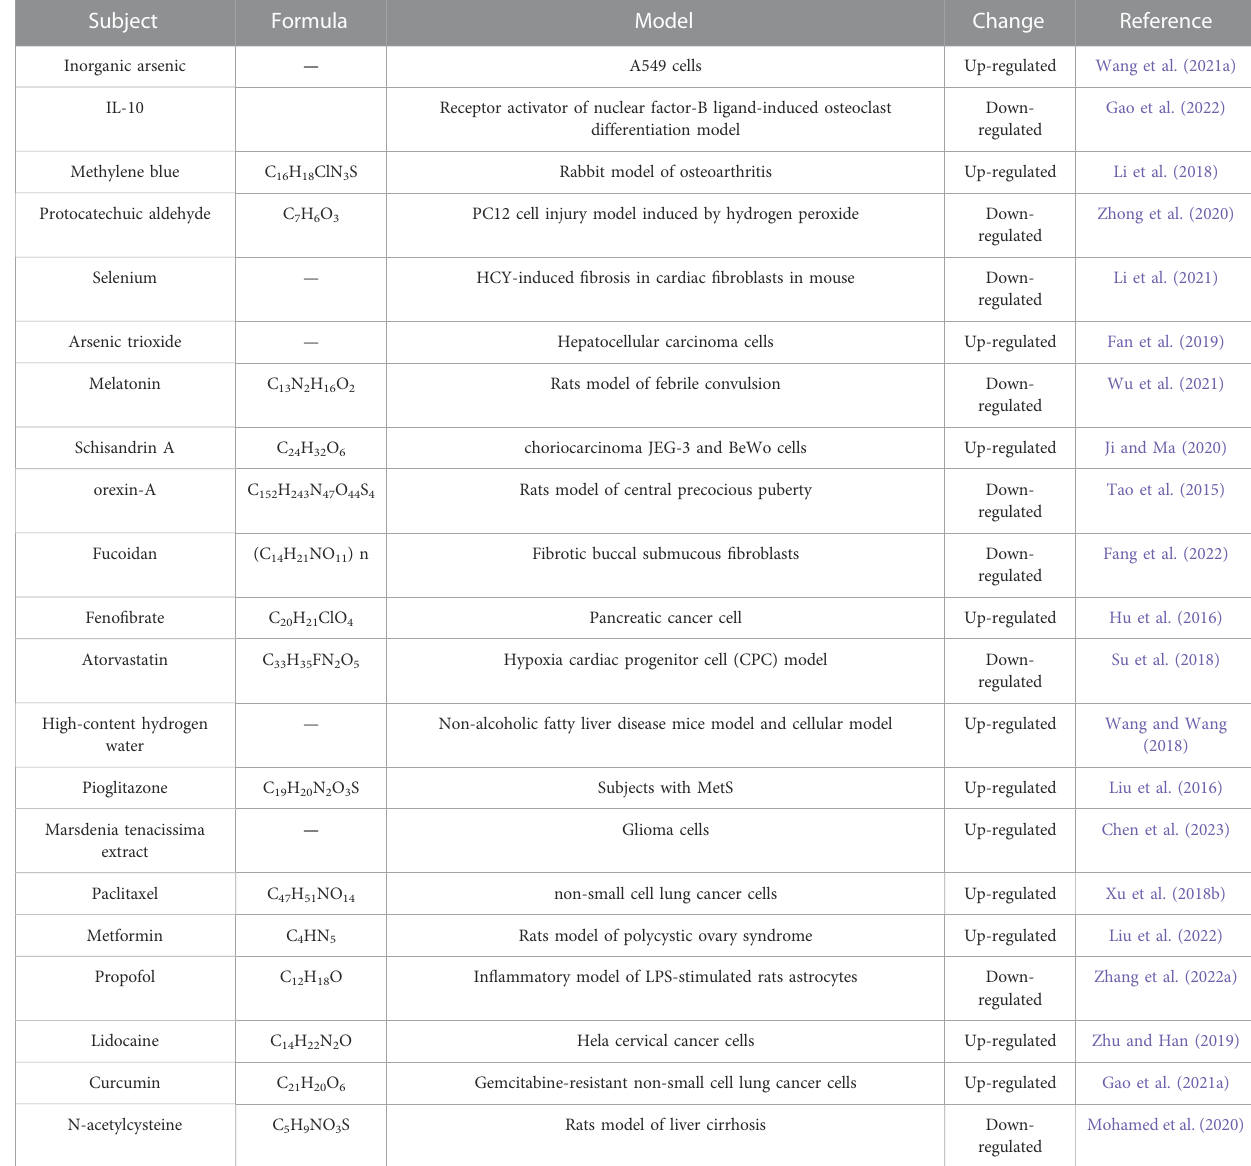
TABLE 3 Potential LncR-Meg3-targeting